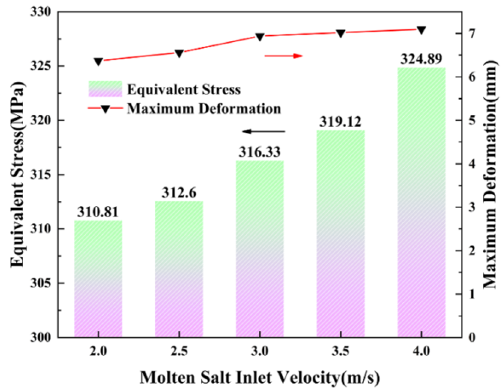
Figure 16. Stress characteristics of heat exchangers with different molten salt inlet flow